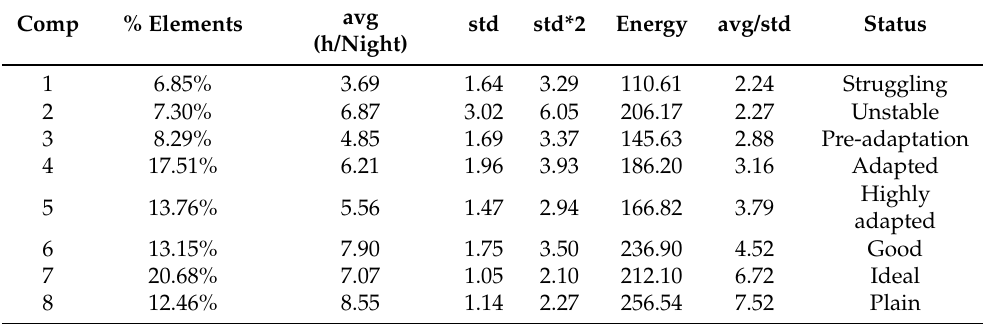
Table 2. Summary of the properties of each of the eight components, including percentage of the snippets in each component, average h/night along with standard deviation and standard deviation*2, energy (summation of the average signal). The order of the components is given by ratio average*1/standard_deviation; that is, the higher in the rank the more hours of use and more regularity (lower standard deviation).